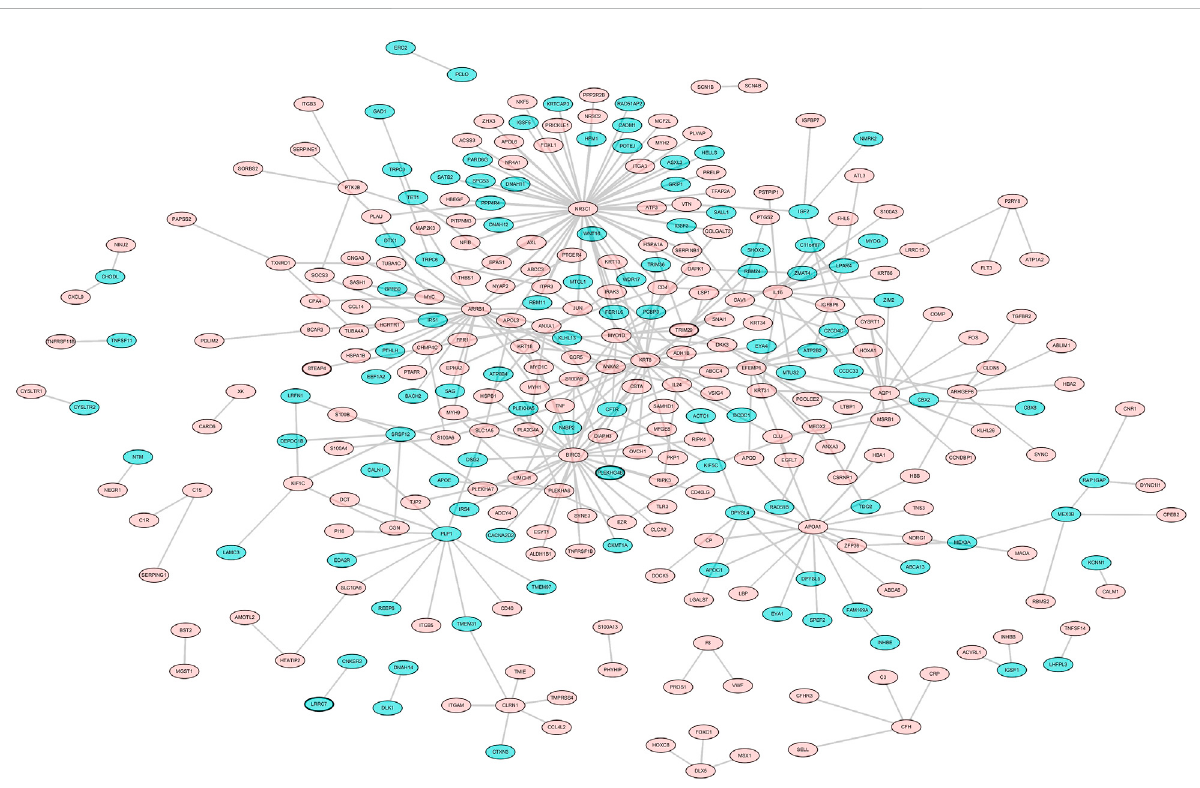
FIGURE 3 Protein – protein interaction (PPI) network analysis. The network comprising the top upregulated (red triangles) and downregulated lncRNAs (green inverted arrows) and their target mRNAs is